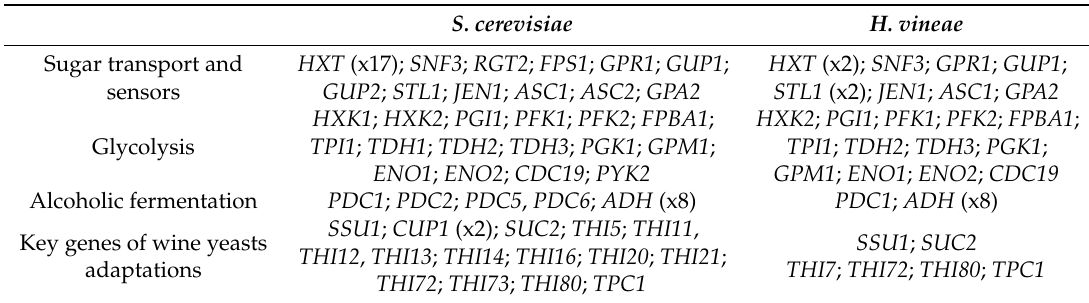
Table 2. Genes involved in sugar transport, glycolysis, and alcoholic fermentation from S. cerevisiae and H. vineae . Gene copy numbers are detailed in